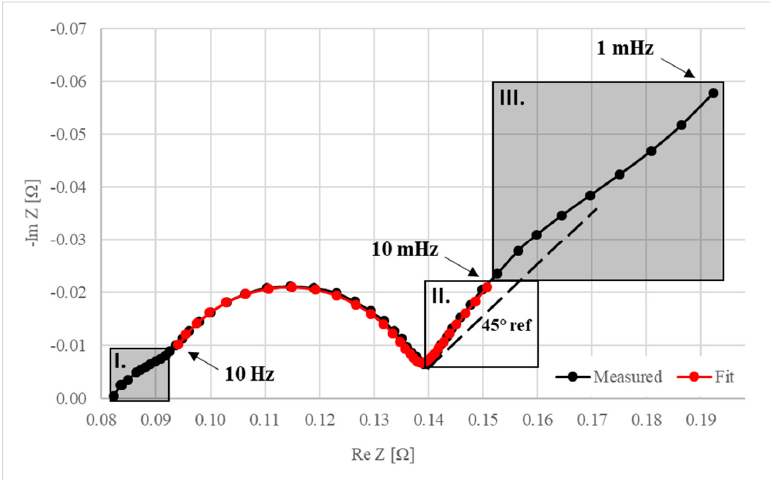
Energies 2020 , 13 , x FOR PEER REVIEW 12 of 23 In order to obtain Randles circuit parameters and electrochemical parameters, EIS measurements were taken. The frequencies of EIS measurements swept from 100 kHz–1 mHz. The Nyquist plot of the inspected cell in its fully charged state at room temperature can be seen in Figure Figure 4. ( a ) The Open-Circuit Voltage (OCV)—State of Charge (SoC) characteristic of the cell, ( b ) Linear Figure 4. ( a ) The Open-Circuit Voltage (OCV)—State of Charge (SoC) characteristic of the cell, ( b ) 5. trend of the measured and fitted instantaneous resistances of the cell. Linear trend of the measured and fitted instantaneous resistances of the cell.